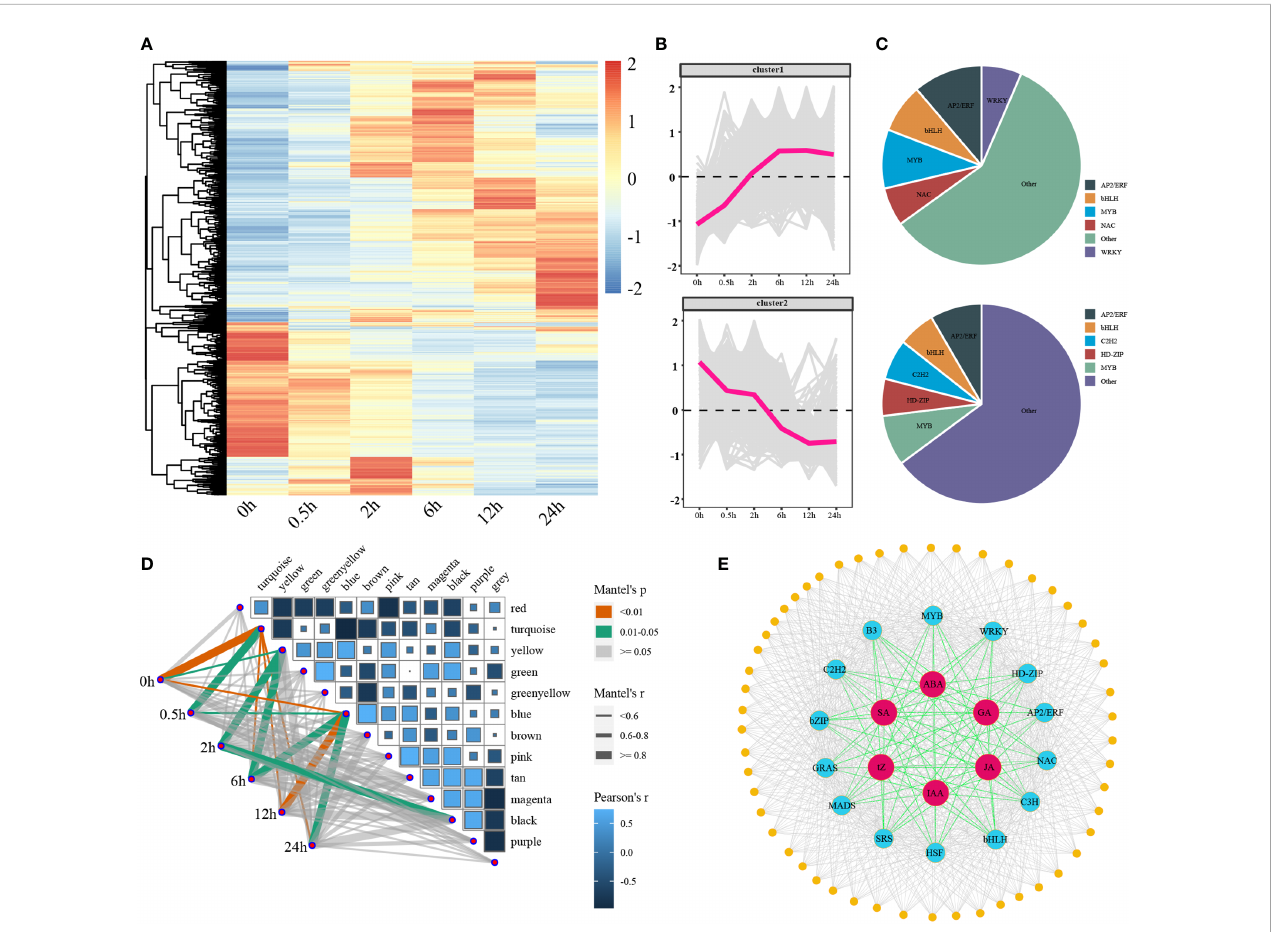
FIGURE 7 The expression patterns of differentially expressed transcription factors under salt stress and the correlations between the modules and stages, as well as the genome-wide co-expression network. (A, B) The heatmaps and line charts of the differentially expressed transcription factors (C) The ratio of core up- and down-regulated transcription factors (D) A heatmap of the relationships between modules and time points, the width of lines re fl ected the strength of correlations (E) A genome-wide co-expression network of hormones, core transcription factors, and target